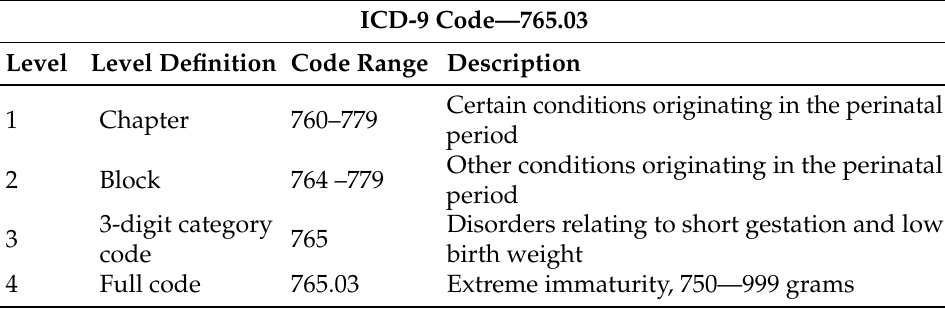
Table 1. Hierarchy of ICD